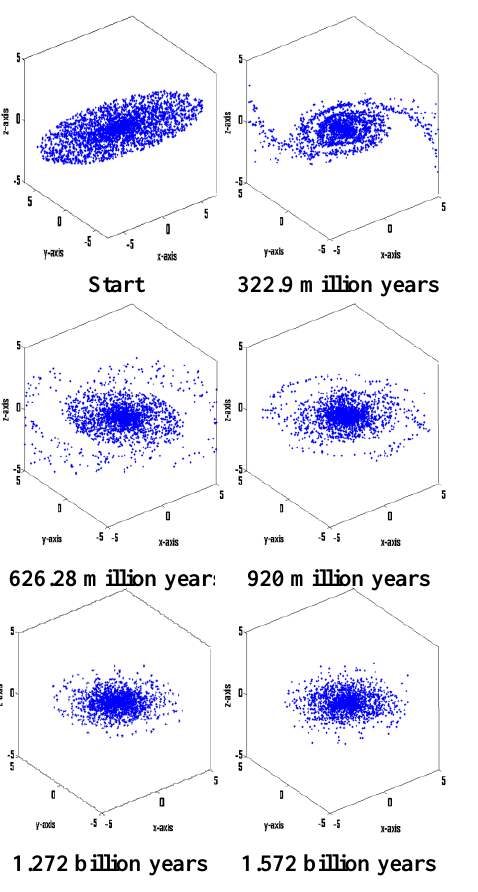
Fig.5: A time sequence of the spiral hot disk model in the xyz plane.